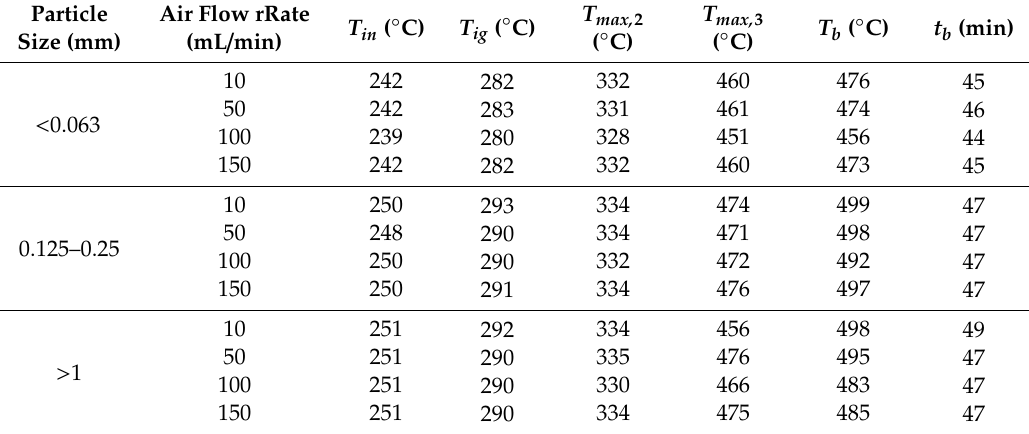
Figure 7. TG and heat flow (( a ), ( b ), and ( c )) and DTG (( d ), ( e ), and ( f )) profiles for the di ff erent particle sizes under di ff erent air flow rates. Table 4. Characteristic temperatures for all the particle sizes under di ff erent air flow